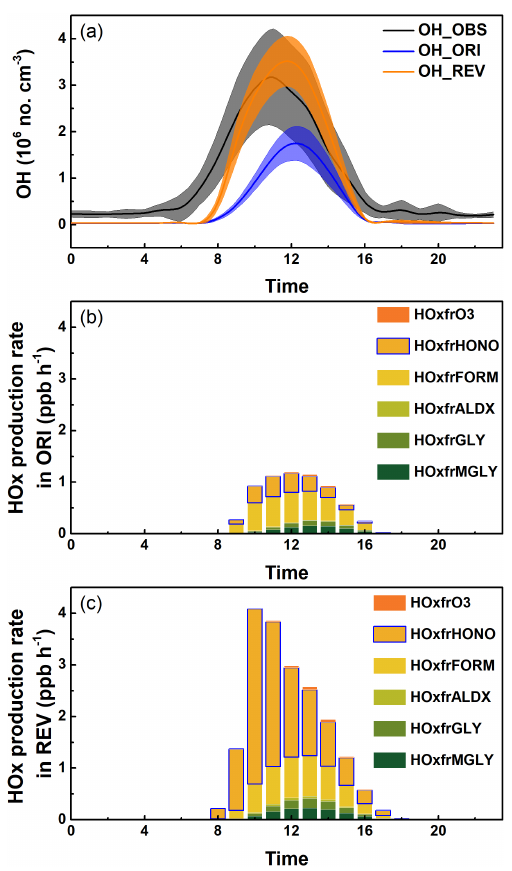
Figure 3. (a) A comparison of simulated and observed diurnal vari- ation of OH. Shading in Fig. 3a indicates the range of observation. (b) HO x formation rates from different photolytic reactions with the ORI case and (c) HO x formation rates from different photolytic reactions with the REV case. The production of HO x from the O 3 photolysis is denoted as HOxfrO3, the production of HO x from the HONO photolysis is denoted as HOxfrHONO, the production of HO x from the formaldehyde photolysis is denoted as HOxfrFORM, the production of HO x from the higher aldehyde photolysis is de- noted as HOxfrALDX, the production of HO x from the glyoxal photolysis is denoted as HOxfrGLY, and the production of HO x from the methyl glyoxal photolysis is denoted as